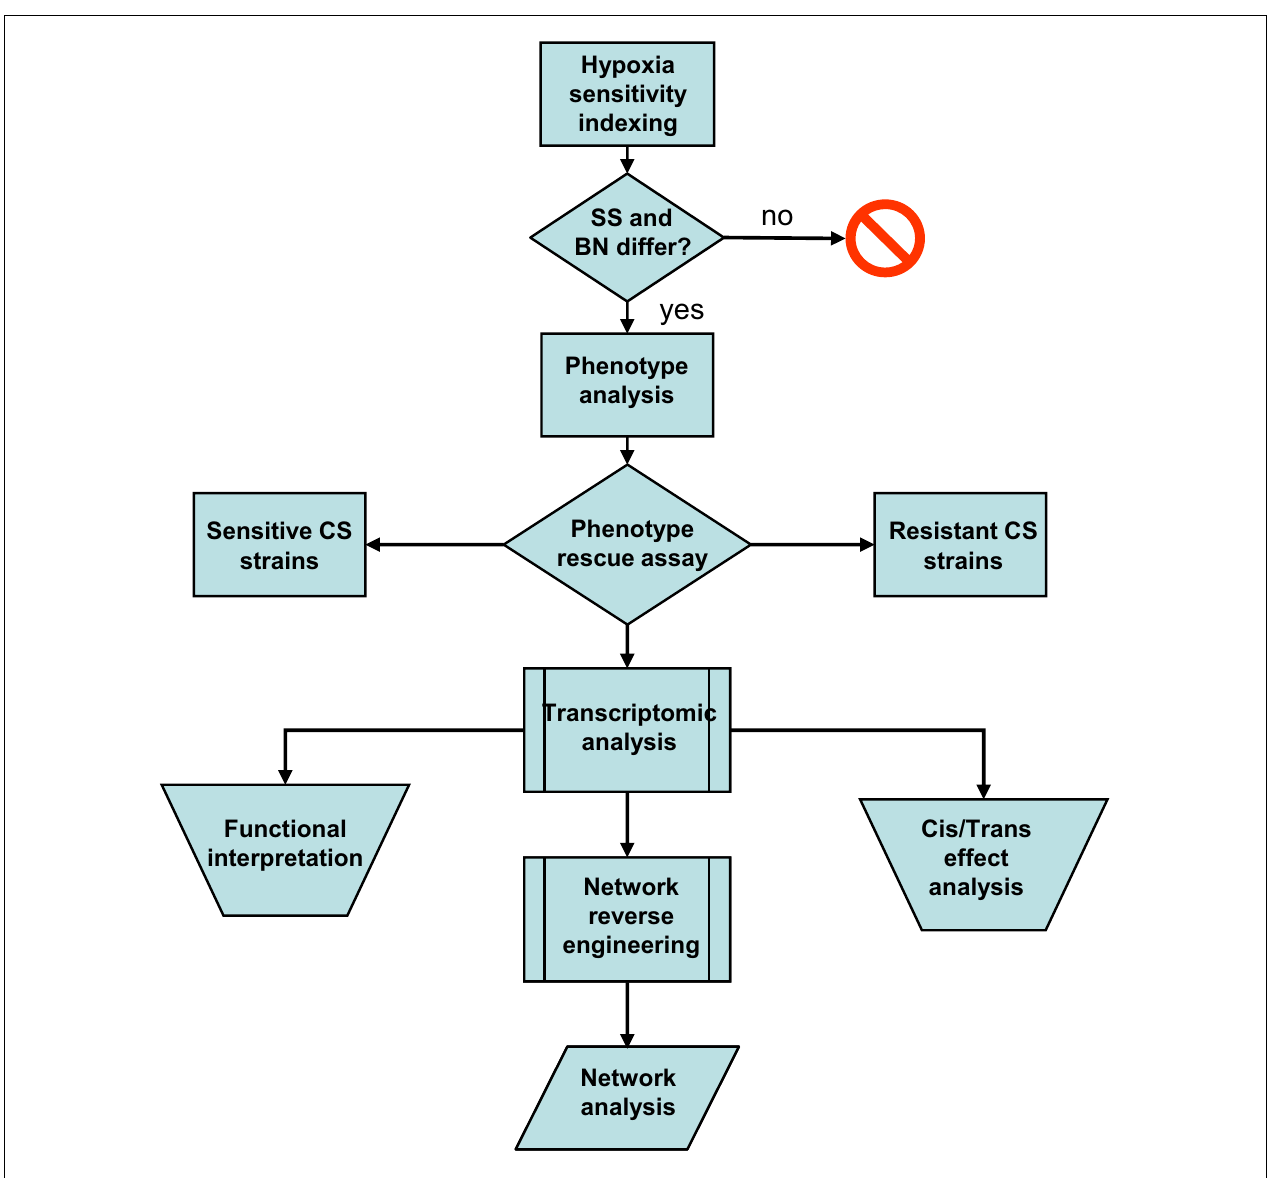
Transcriptomic data were analyzed in order to assess the functional implementations of the hypoxia responses and the manifestation of cis/trans-effects. A co-regulation based genetic interaction network was reversed engineered using an information theoretic network remodeling